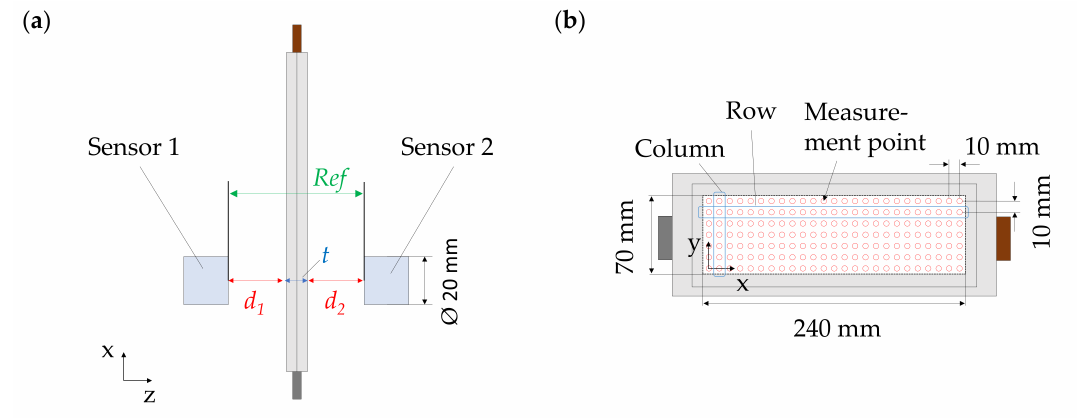
Figure 4. ( a ) Sketch of the measuring principle to obtain the cell thickness t . ( b ) Sketch of the 175 measurement points along the cell surface.